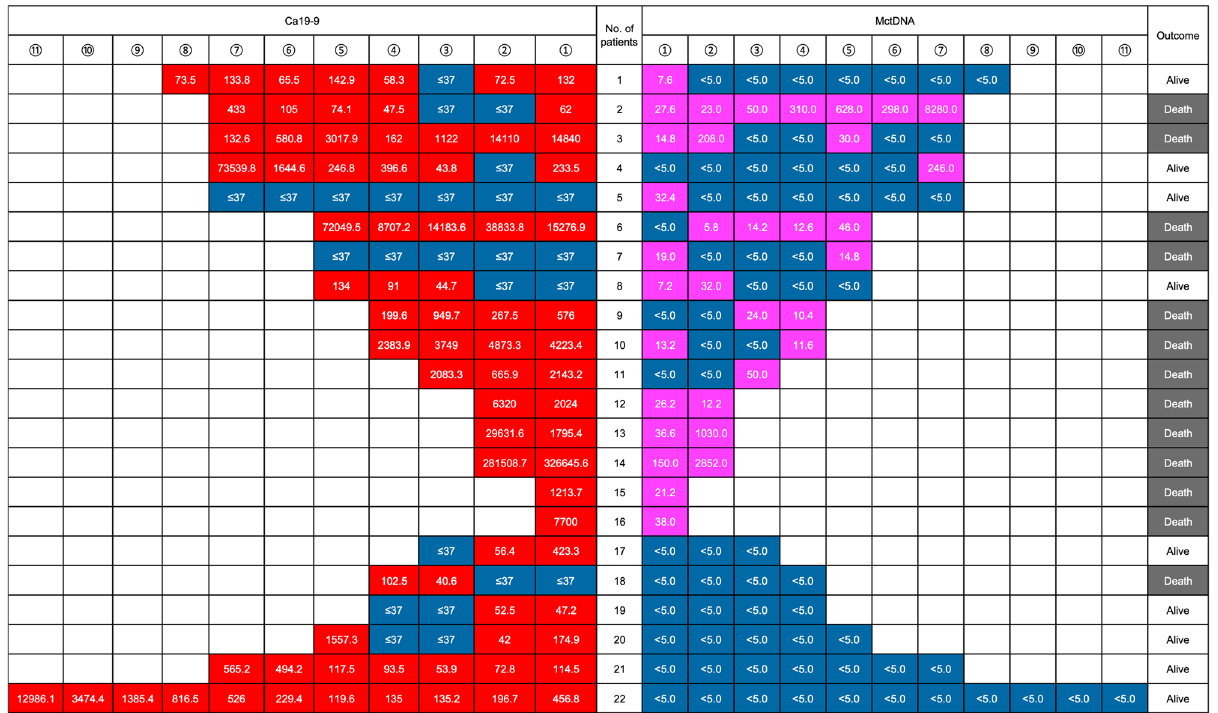
9” and “MctDNA”, respectively, and are ordered as per the timing of blood examination during chemotherapy (1 → 11). CA19-9< 7 U/mL and no detection of KRAS -mutated ctDNA are represented in blue, whereas CA19- 9≥37 U/mL and the emergence of KRAS -mutated ctDNA are represented in red and pink. The number in the box under “CA19-9” and “MctDNA” represents the CA19-9 value (U/mL) and the result of KRAS -mutated ctDNA analyses (copies/1 mL plasma). The negative threshold of copy number and CA19-9 were indicated as “< 5 copies” and “ ≦ 37”, respectively. Prognosis is shown under “Outcome”, with “Alive” and “Death” indicated in white and gray, respectively. Examination results for every three months are shown in one cell; thus, four cells correspond to approximately one